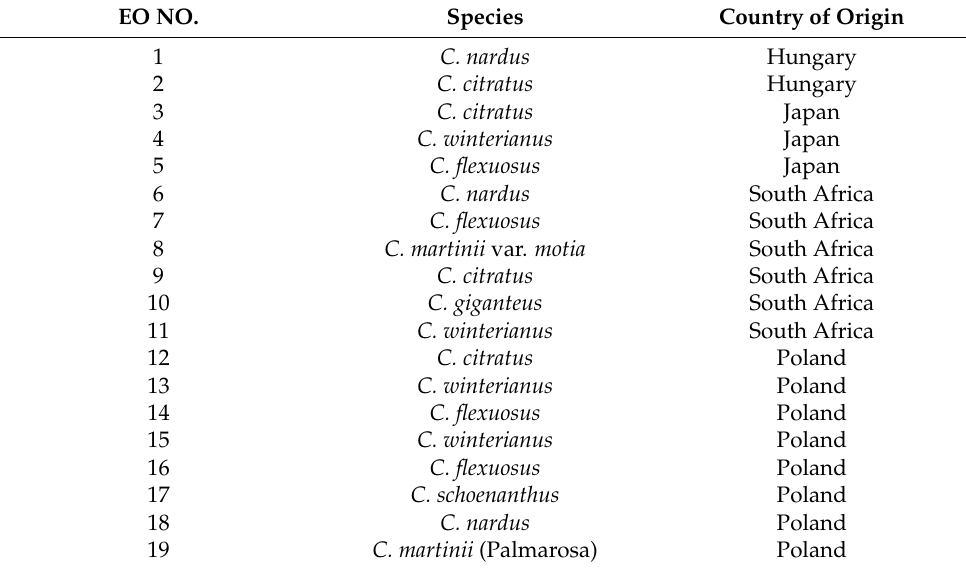
Table 4. Numeration of essential oils with their taxonomies and sources. EO